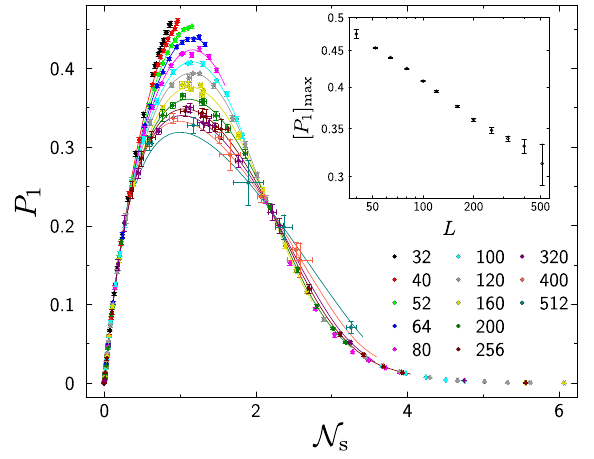
FIG. 14. Parameter-free scaling: P 1 ð J Þ as a function of the J Þ of spanning curves. Inset: Size depend- average number N s ð ence of the maximum of P 1 ð J Þ on a double logarithmic